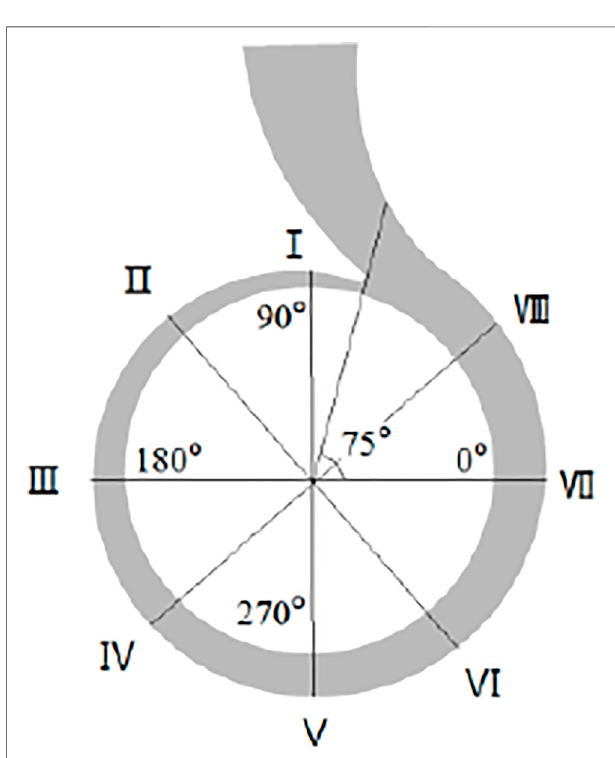
FIGURE 7 | Circumferential angle and cross-section distribution of the